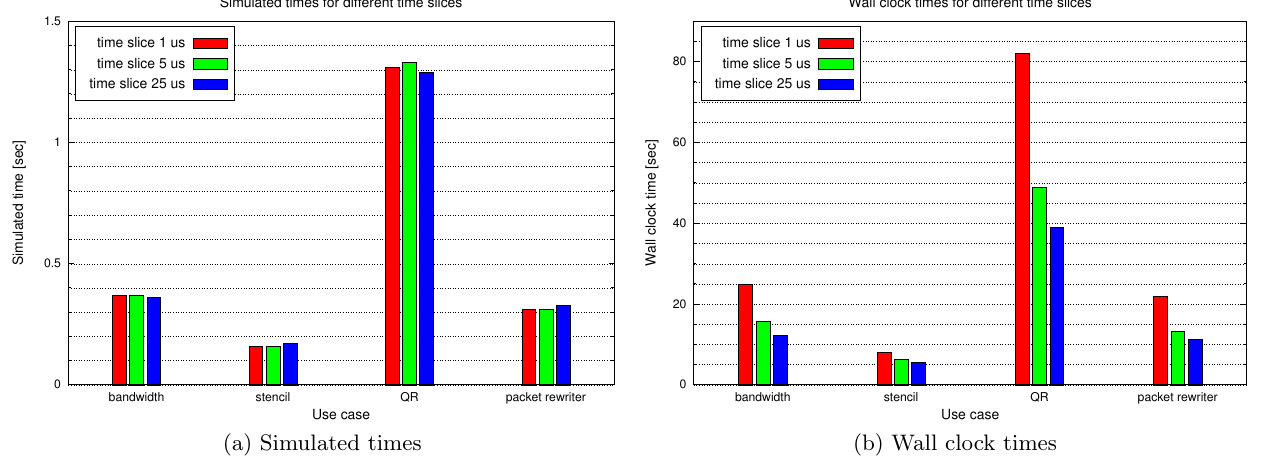
Figure 4: Simulated times and wall clock times of the four use cases for time slices 1us, 5us and 25us. For clarifying that circumstance, Figure 5 shows the av- erage wall clock times per simulated second of the different use cases.